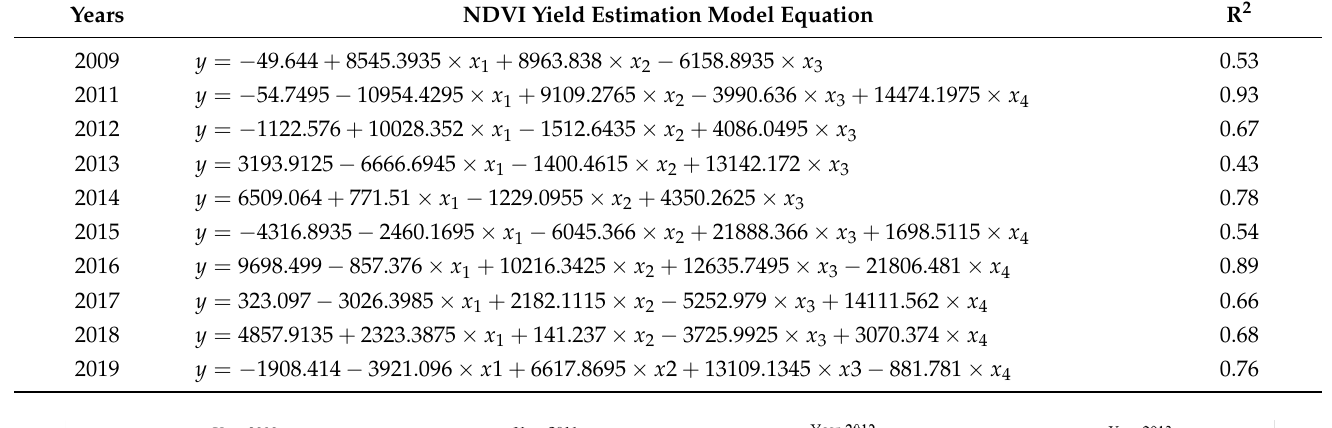
Table 3. Yield estimation model based on long time series.